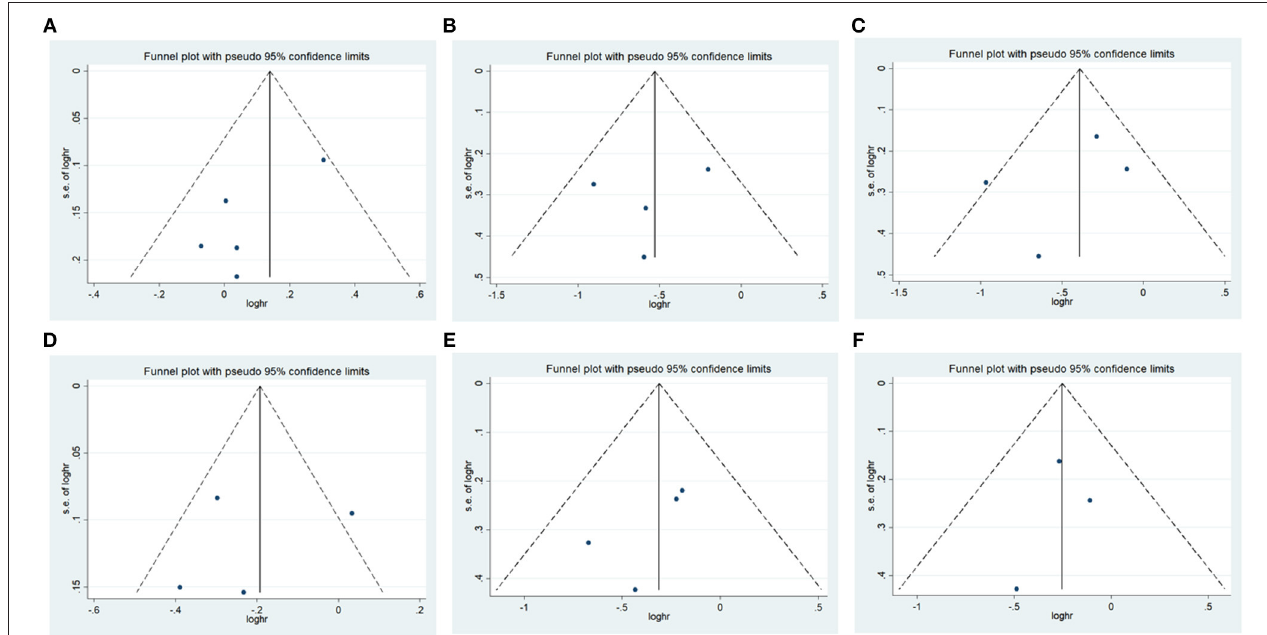
FIGURE 5 | Funnel plot of the odds ratios in the meta-analysis. (A) IREB2 rs2568494 dominant model, AA + GA vs. GG. (B) IREB2 rs2656069 recessive model, GG vs. AA + AG. (C) IREB2 rs2656069 additive model, GG vs. AA. (D) IREB2 rs2656069 allele model, G vs. A. (E) IREB2 rs10851906 recessive model, GG vs. AA + AG. (F) IREB2 rs10851906 additive model, GG vs.